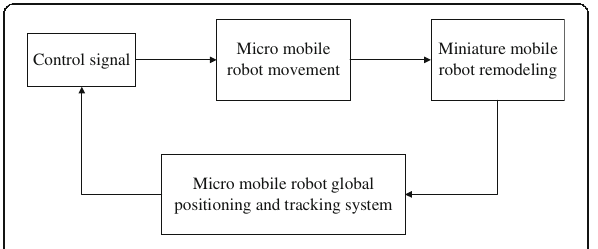
Fig. 1 Flow chart of a miniature mobile robot experimental